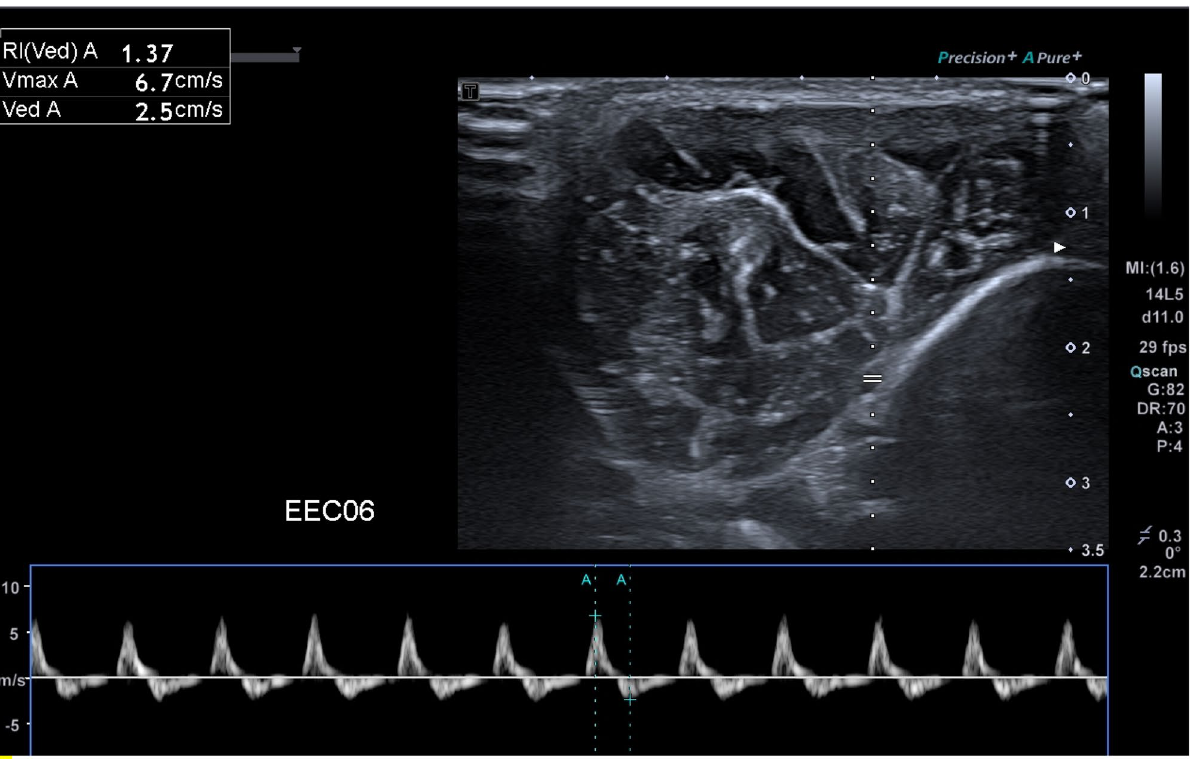
Figure 8. Anterior tibial arterial blood flow velocity.